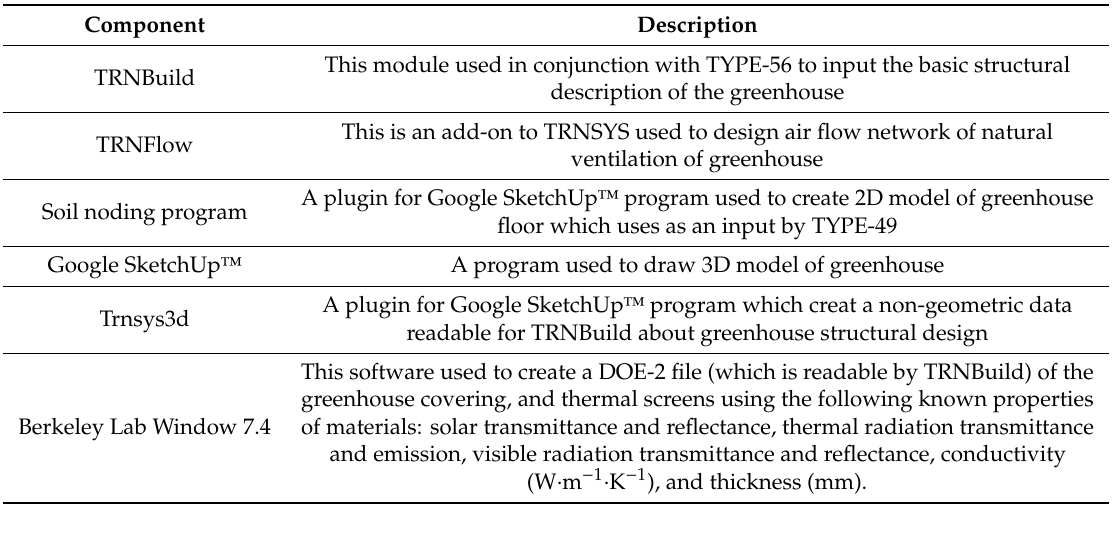
Table 3. Description of TRNSYS 18 and other programs used in the simulation process.